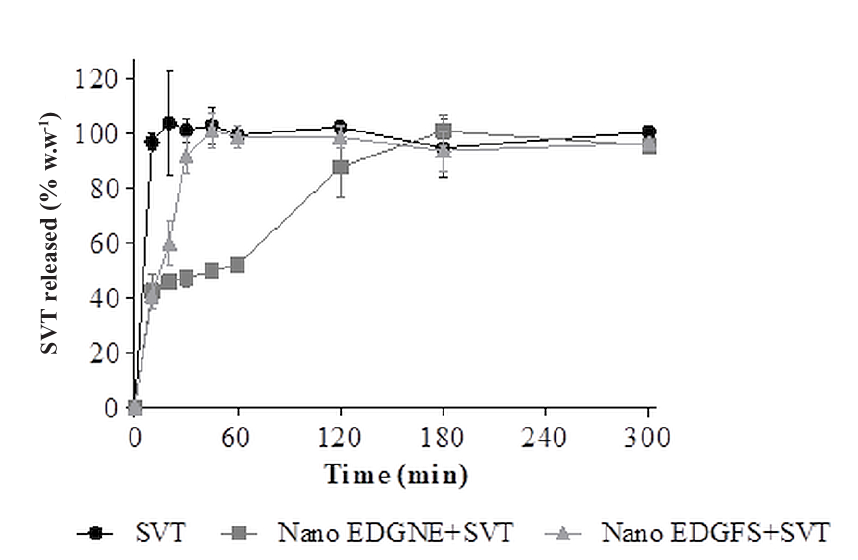
FIGURE 6 - Release profile of nonencapsulated simvastatin (SVT) and SVT incorporated into Nano EDGFS+SVT and Nano EDGNE+SVT. USP type II dissolution apparatus (paddles), 900 mL of phosphate buffer (0.05 mol.L -1 ) pH 7.0, plus